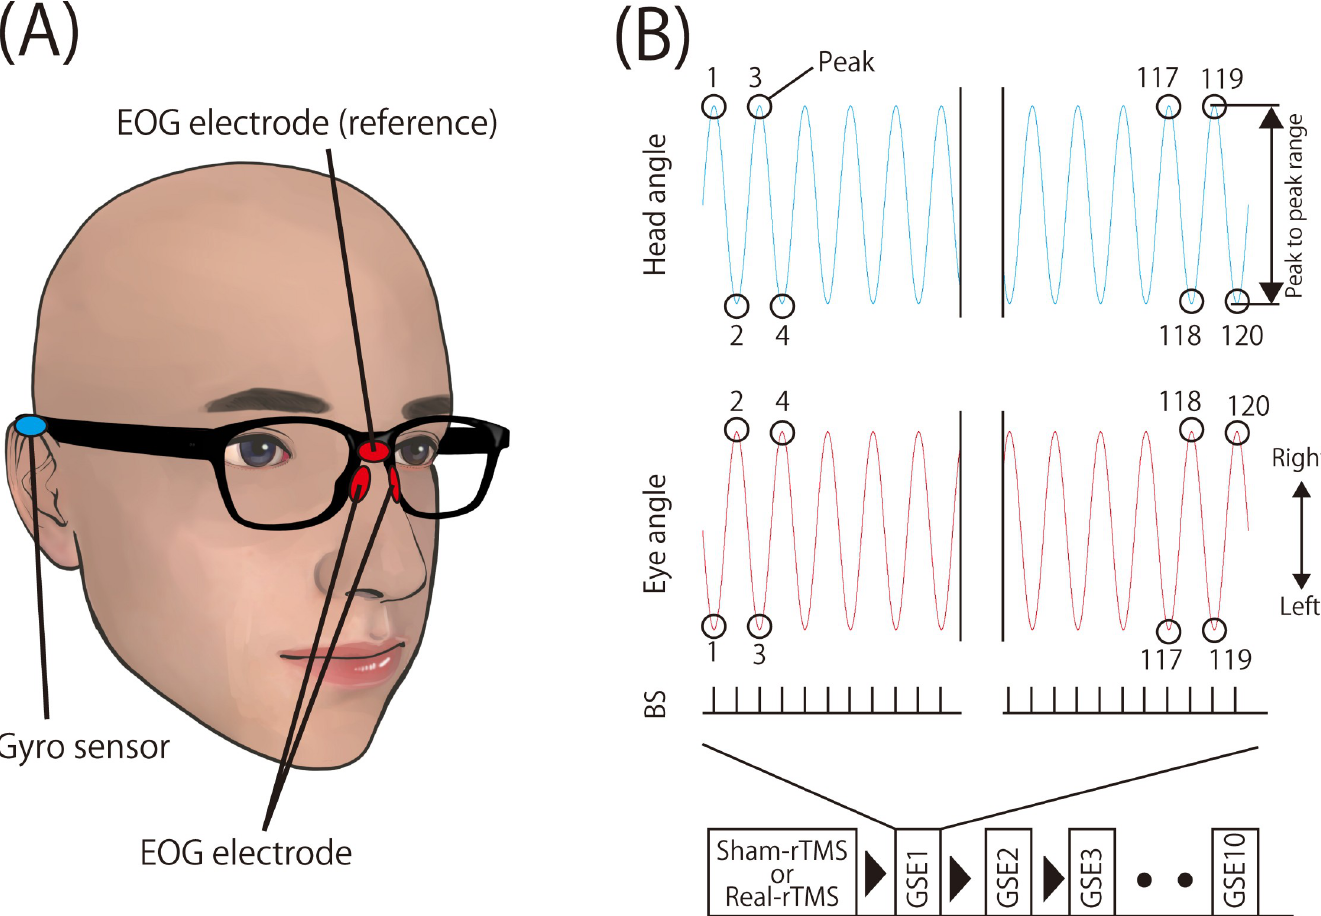
Fig 1. Experimental setup (A) and data analysis (B). (A) The black glasses shown are the JINS MEME EOG glasses. The red ovals indicate the EOG electrodes, and the blue ovals indicate the gyroscope sensor attached within the glasses. (B) The blue line indicates the range of the head, and the red line indicates the range of the eye during the GSE. BSs are shown below the range line as short vertical lines. The BS interval was set at 500 ms for 60 s (total number of BSs = 120). The empty circles indicate the peak range, and the number “1” in the figure indicates the first peak of the range of motion. The number continues to the 120th peak. The lower panel in (B) is a schematic of the experimental procedure. The GSE interval was set at 1